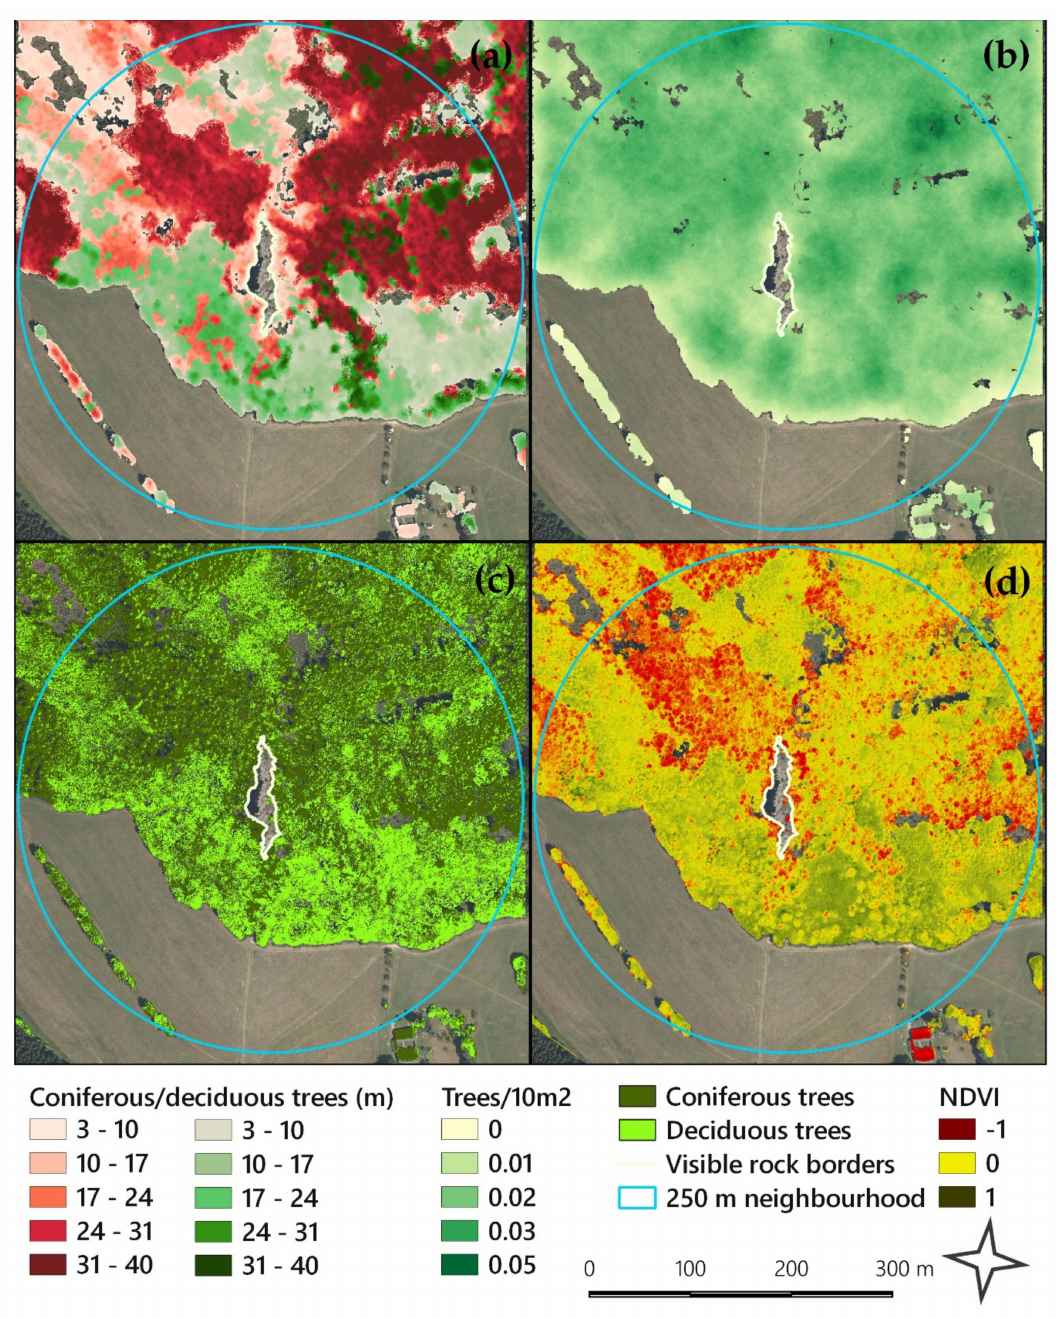
Figure 8. ( a ) Canopy height model—coniferous (red) and deciduous (green) trees and their heights, ( b ) stand tree density—number of trees per 10 m 2 , ( c ) the result of orthophoto pixel classification into deciduous or coniferous trees, and ( d ) NDVI (normalized difference vegetation index)—values below zero generally corresponded to coniferous trees, whereas the values above zero indicated deciduous